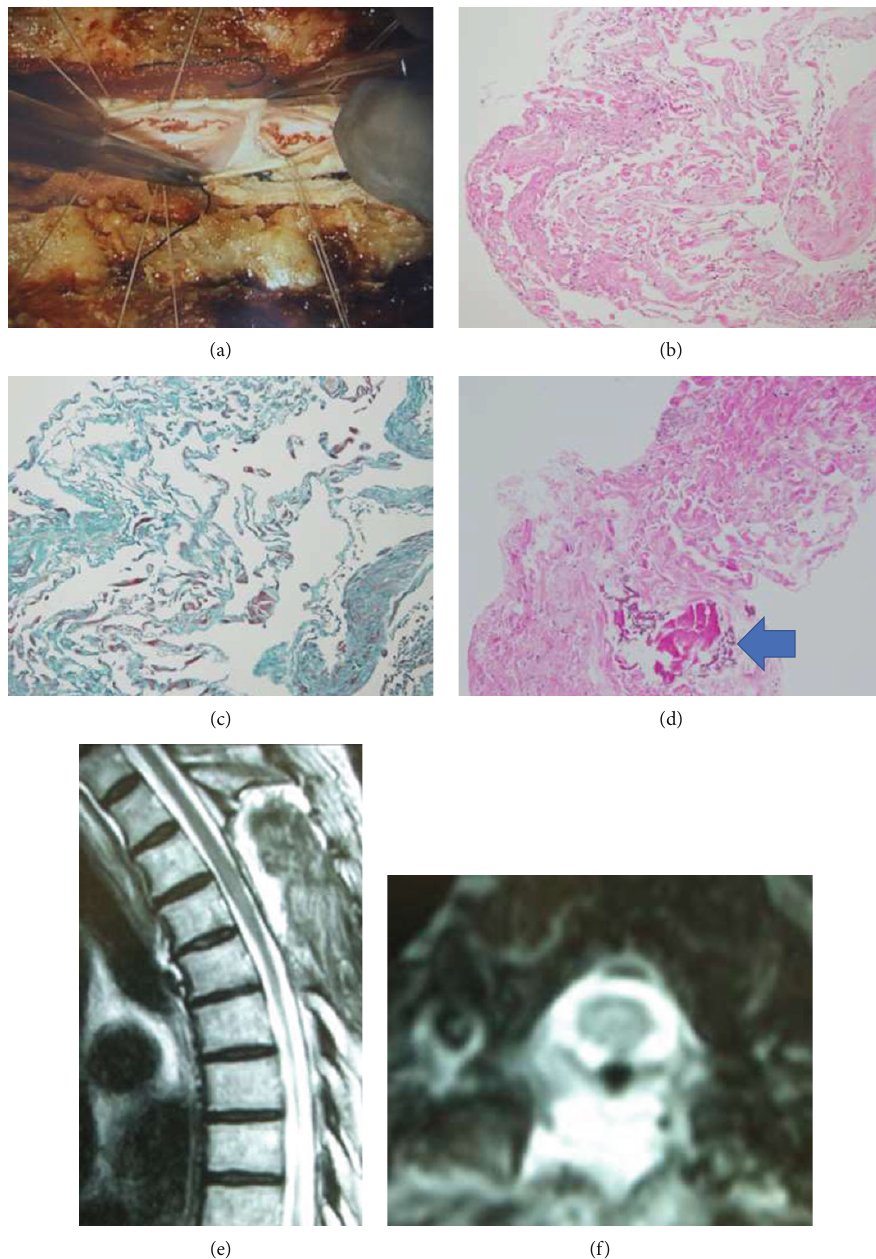
Figure 2: (a) Intraoperative fi ndings show a membrane-like structure in the subarachnoid space. (b) Fibrous tissue seen on hematoxylin and eosin staining. (c) Epithelial membrane antigen-positive epithelial tissue is seen. (d) Calci fi cation seen on hematoxylin and eosin staining (arrow). (e, f) On postoperative MRI, the spinal cord deviation and scalpel sign have